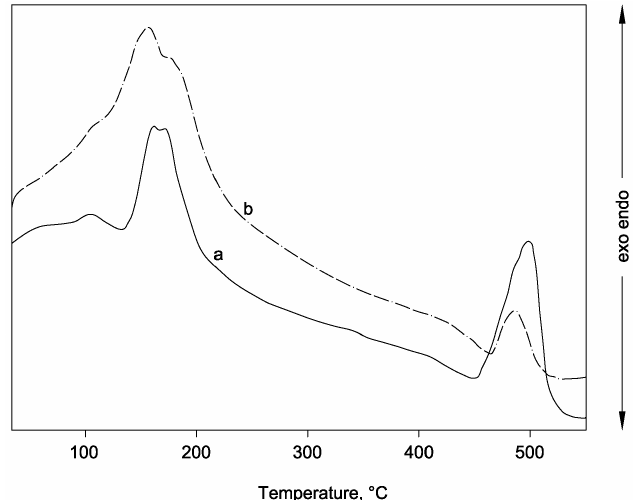
Figure 6. Thermal analysis results for the system C ( b ) 28 days.